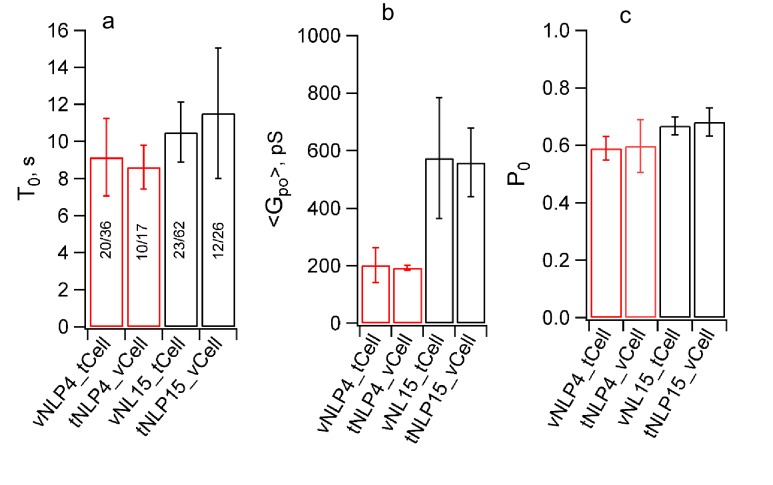
Swapping the locations of the v- and t-SNAREs does not affect pore properties.Flipped v-SNARE cells were fused with t-SNARE NLPs (loaded with 4 or 15 total copies of t-SNAREs, tNLP4 and tNLP15), inverting the target membrane. For a given SNARE copy number in NLPs, burst lifetime (a), mean open-pore conductance (b), and probability that a pore is open during a burst were indistinguishable between the vNLP_tCell and tNLP_vCell configurations. The number of patches/pores are indicated for each condition in (a). The same numbers apply to (b) and (c). For vNLP_tCell fusion, results are copied from Figure 5 and Figure 5—figure supplement 1 to facilitate comparison.